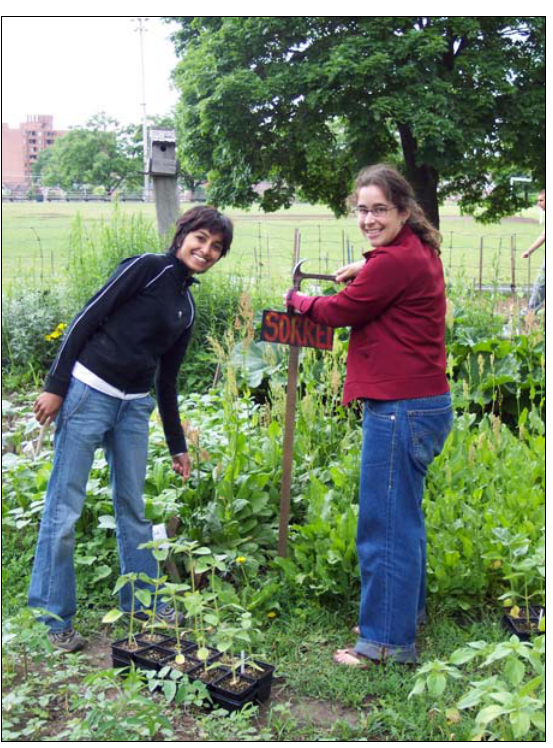
Figure 2: Community Gardens Figure 3: Composting